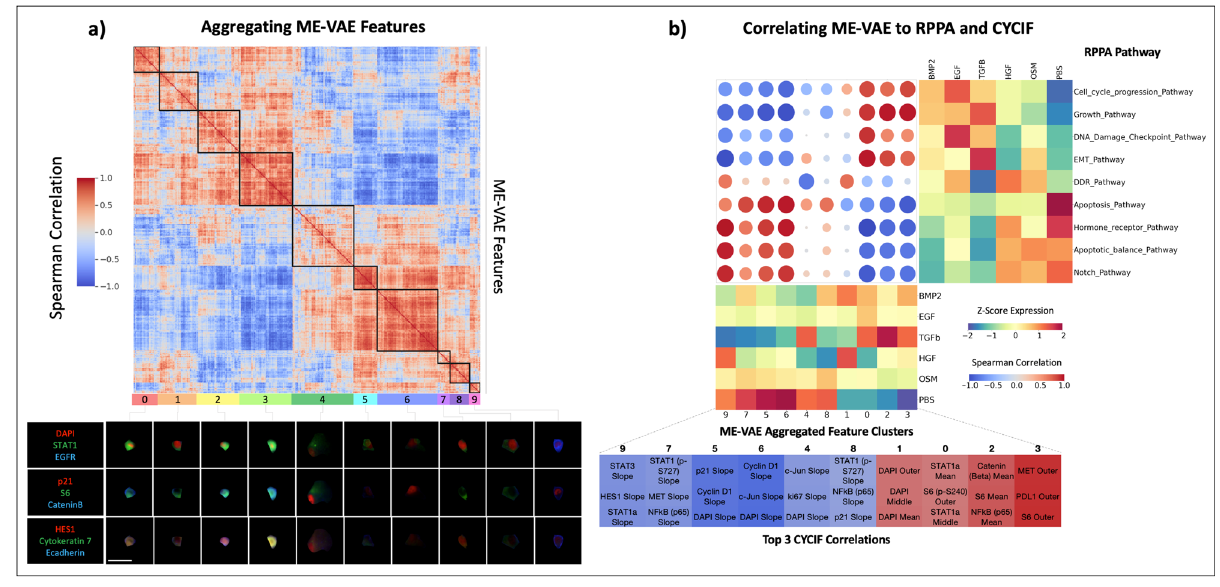
Fig. 4 ME-VAE feature aggregation and transitive inter-modality correlation. a Using the single-cell observations as features, correlations are drawn between pairs of ME-VAE features. These features are then hierarchically clustered to observe patterns and reduce VAE features to aggregated feature sets. Cell images were assigned aggregated feature scores using the mean expression of each feature in a cluster. Shown are representative cells that are highly expressing for each respective cluster. Scale bar represents 20 μ m for all single-cell images. b Correlation matrix between RPPA pathway activity scores and ME-VAE aggregated features. Samples from the two modalities were paired by their ligand treatments, resulting in a sample size of n = 6 biologically independent ligand treated cell populations. RPPA pathways and VAE features were hierarchically clustered to show prominent patterns in correlation. ME-VAE aggregated features were also correlated to several metrics of CYCIF expression (mean inner, mean middle, whole-cell means, and radial slope) for all 23 stains. This CYCIF correlation was done using the full dataset of single-cell images (sample size n = 73,134 single-cell images). The table of CYCIF correlations shows the top three correlations for each ME-VAE aggregated